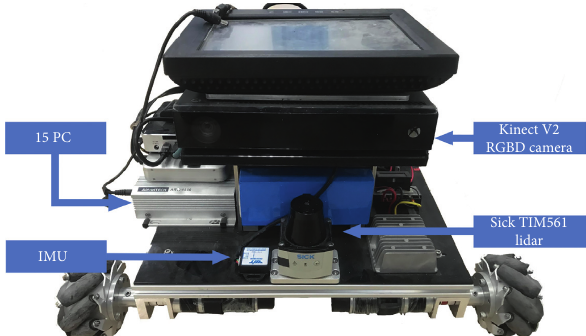
Figure 7: Experiment platform: the Meconium-wheel mobile